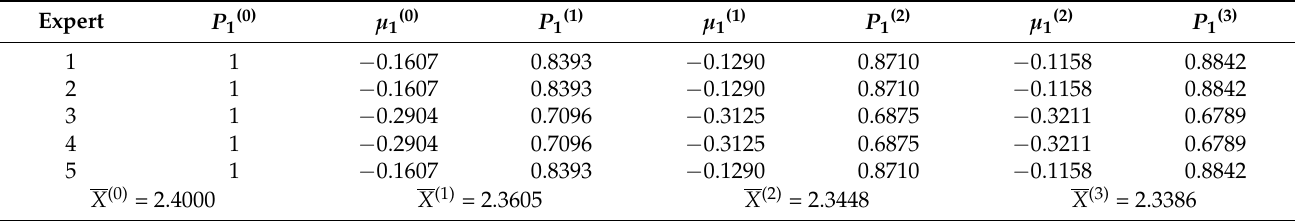
Table 8. Correction of fracture zone.